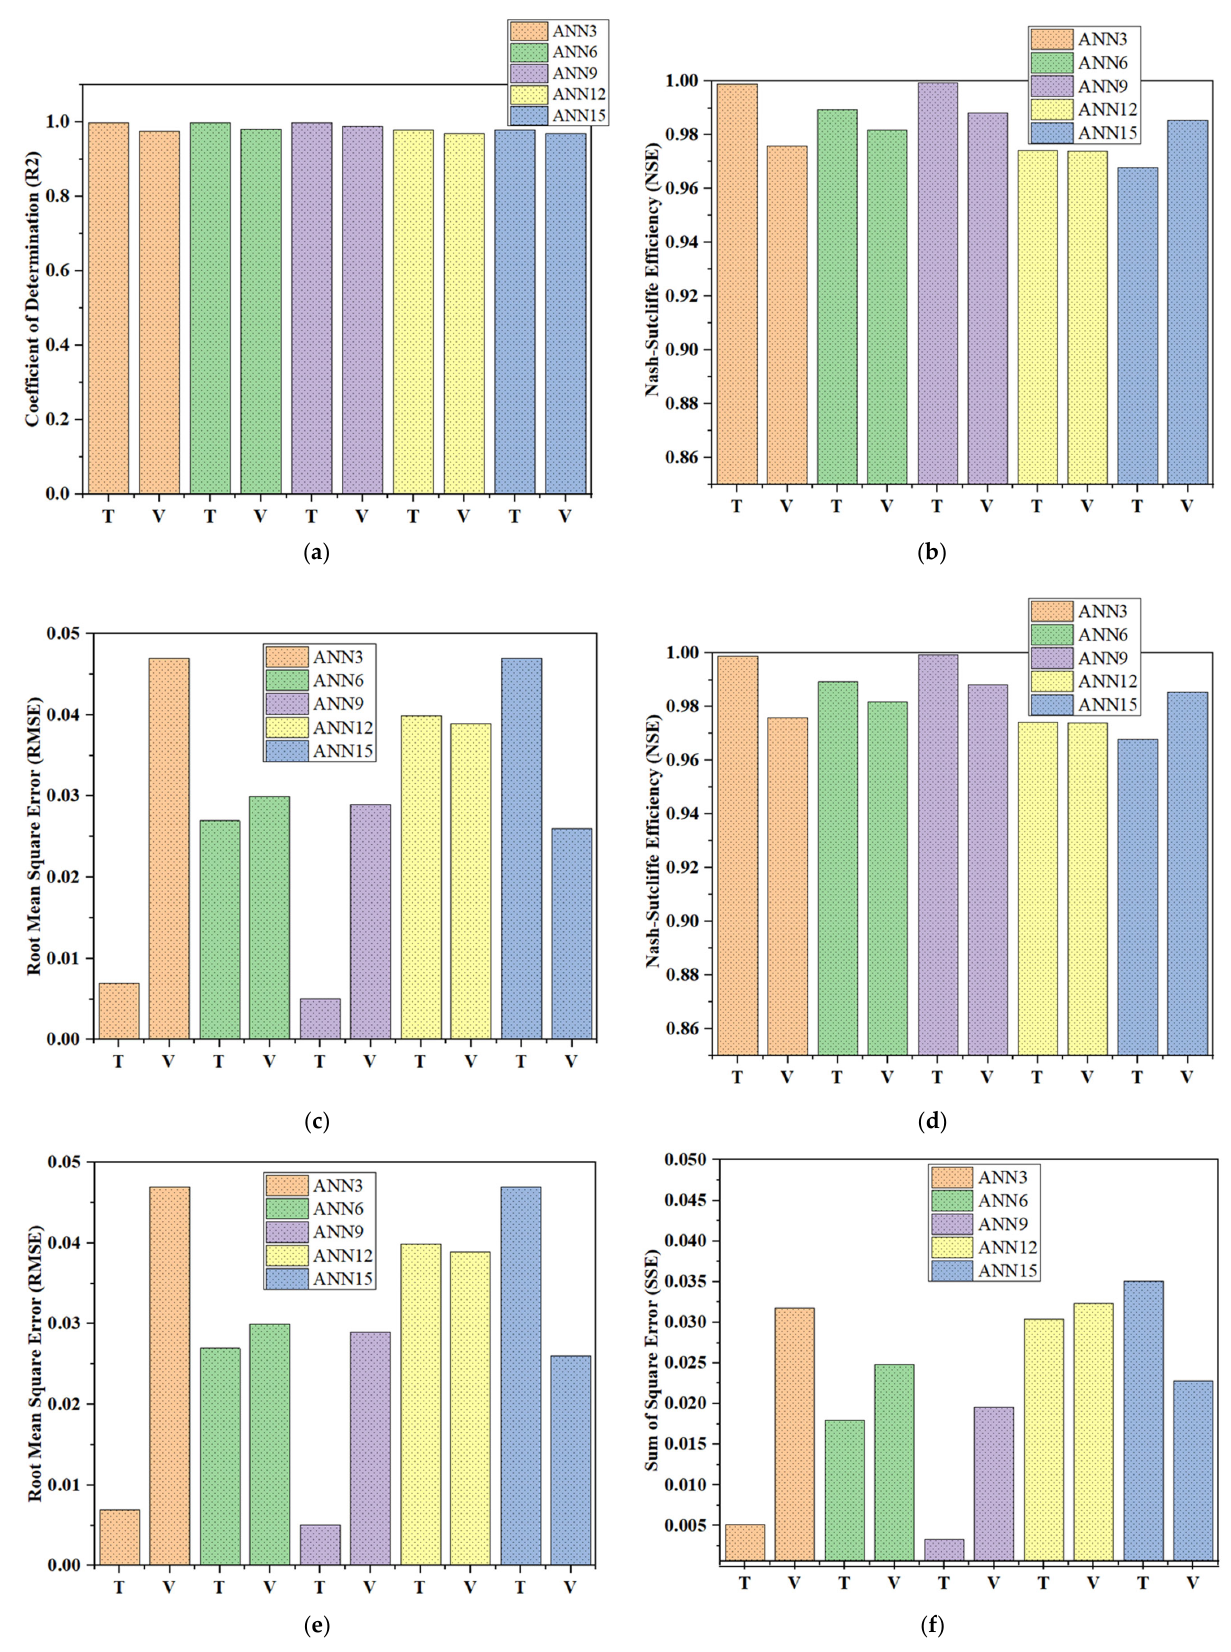
Figure 6. Performance indicators for ANN models: ( a ) R 2 ; ( b ) NSE ; ( c ) RMSE ; ( d ) SSE ; ( e ) MAE ; and ( f ) comparison b/w experimental and computed C BD .